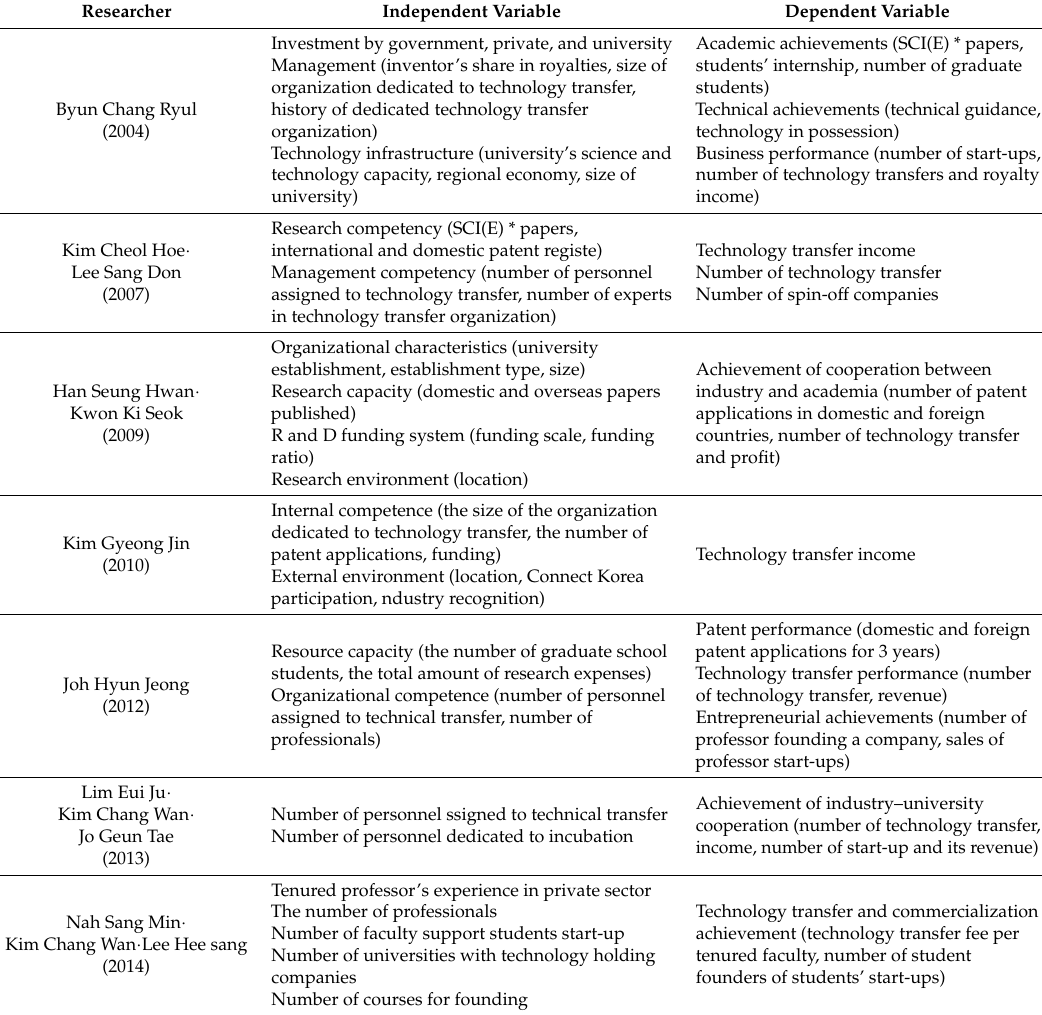
Table 1. Factors affecting university–industry cooperation